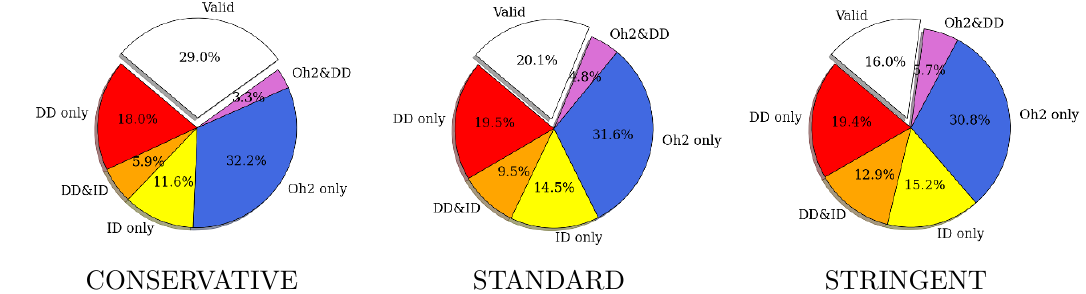
Figure 14 . Fraction of pMSSM points excluded by upper bound of the dark matter density, direct detection and indirect detection